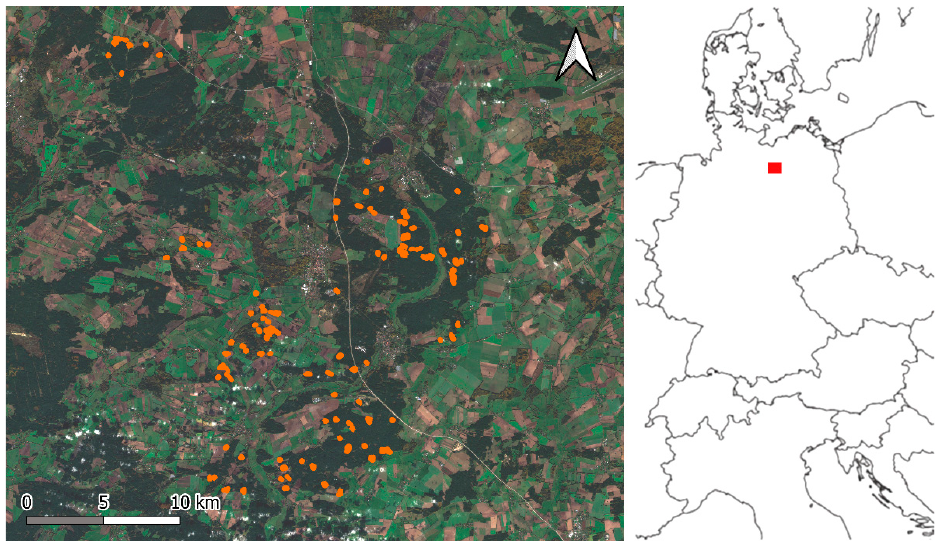
Figure 1. Location and overview of the study area. Selected damage polygons are marked in orange on a satellite image of the entire extent of the area. The red rectangle on the overview map corresponds to the image. The Sentinel-2 RGB image is centered to the municipality of Ludwigslust (Mecklenburg-Vorpommern, Germany), acquired on 06 November 2017. (A detailed overview with damage categories and exemplary subsections is shown in Figure A1.)